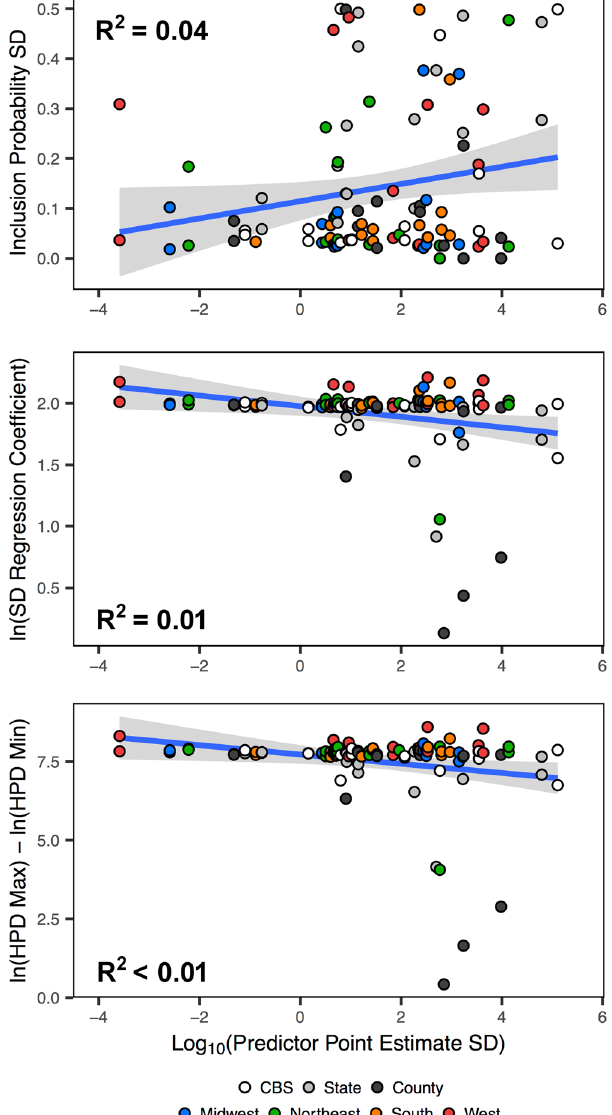
Figure 3. Linear correlations between the variance of predictor point estimates and the variance in posterior support metrics. The blue lines represent the lines of best fit and the shaded areas represent the 95% confidence intervals, and include data for all national and regional